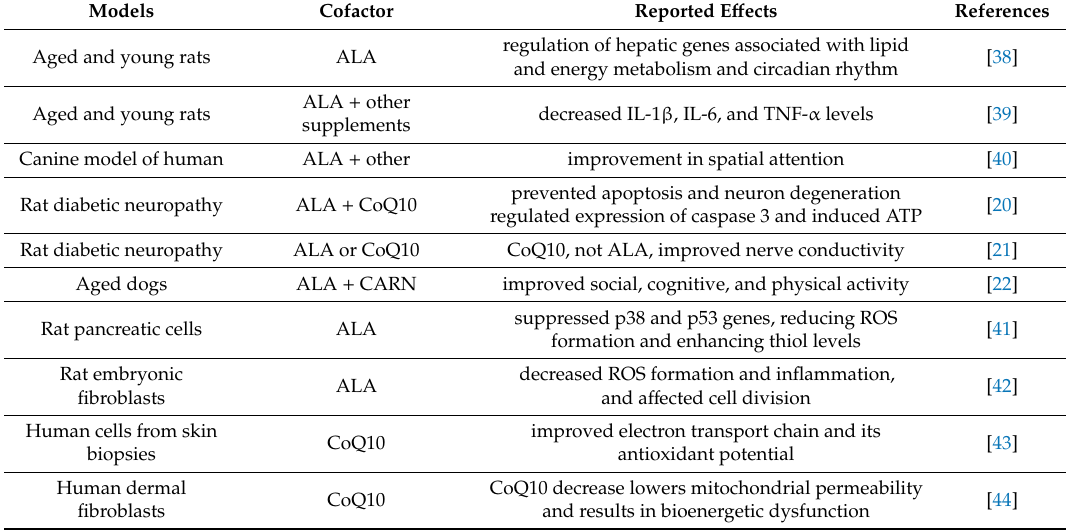
Table 1. Main e ff ects of mitochondrial cofactors (ALA, CoQ10, and CARN) in aging-related animal and in vitro